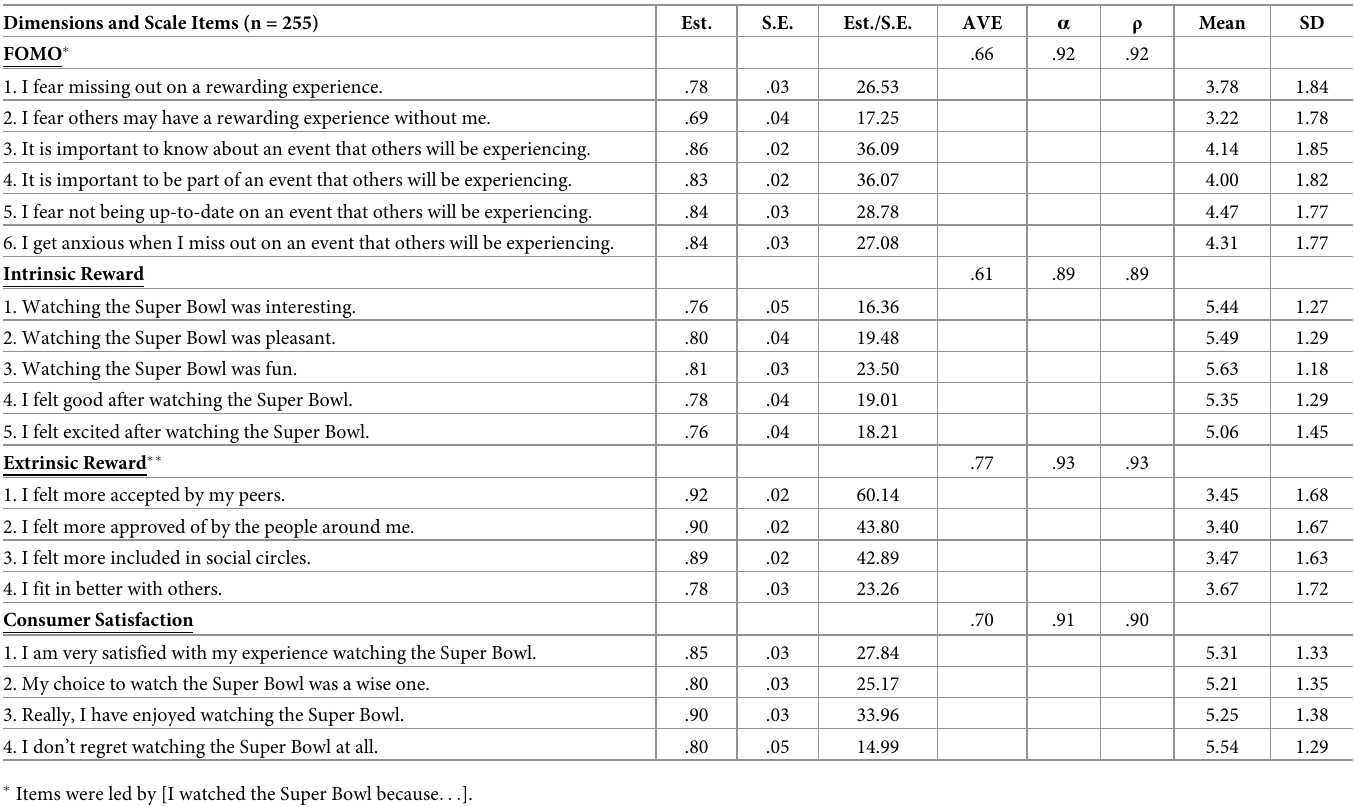
Table 2. Study 2: Psychometric